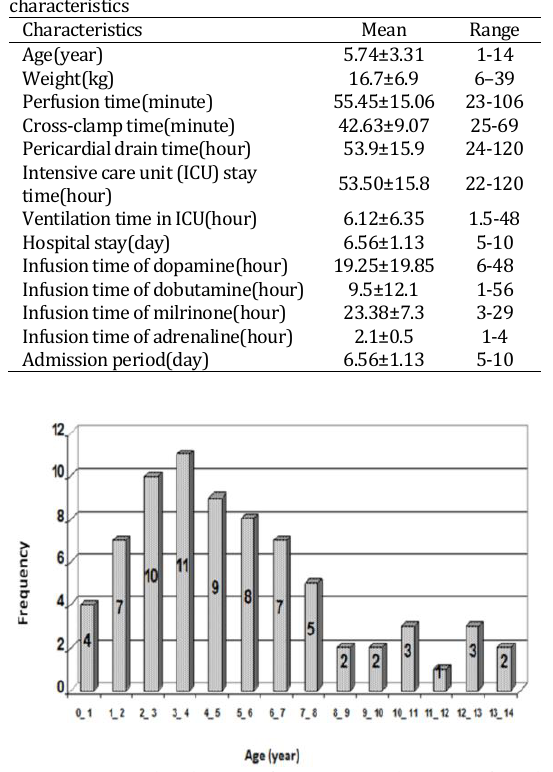
Figure 1. Age distribution of patients at the time of total correction of tetralogy of Fallot among patients were 24 (32.4%), 23 (31.1%), 22 (29.7%), and 5 (6.8%), respectively. Preoperative variables were noted in Table 2.